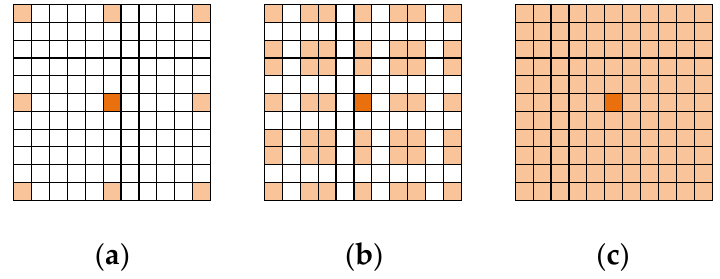
Figure 4. Odd – even mixed dilation rates. ( a ) r = 5; ( b ) r = 2; ( c ) r = 1. Features at various levels contain diverse information distribution. The lower-level features contain rich spatial structure information, but their high resolution leads to weak global background information. The higher-level features have rich semantic information and can effectively classify hyperspectral images, but their poor resolution lacks spatial details for the hyperspectral images [26]. For this reason, the fusion of these different levels of feature information can significantly strengthen the classification accuracy of hyperspectral images. The paper proposes DMLPFFN, which can extract sufficiently different level features by fusing three feature extraction branches, as shown in Figure 1.